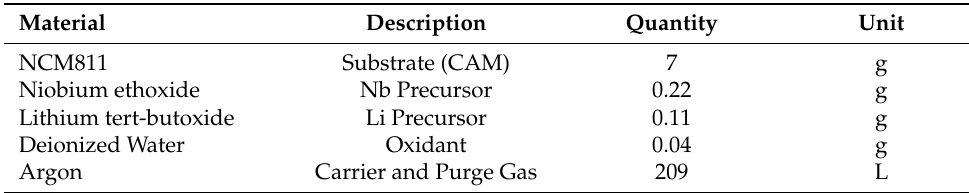
Table 1. Input Materials